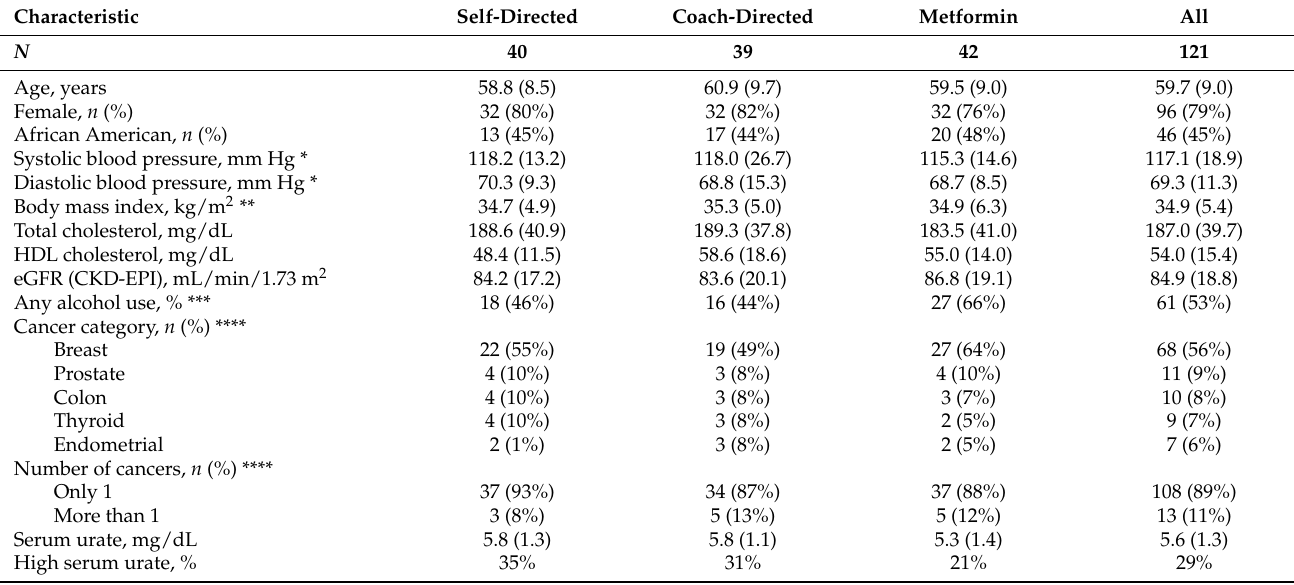
* N for systolic and diastolic blood pressure is 120 (one measurement missing from the metformin arm). ** Baseline body mass index was based on the average of two weight measurements performed prior to randomization. *** N for alcohol use is 116 (39 self-directed, 36 coach- directed, 41 metformin). **** Less common cancers not represented. Abbreviations: CKD-EPI: chronic kidney disease-epidemiology collaboration equation; eGFR: estimated glomerular filtration rate; HDL: high density lipoprotein